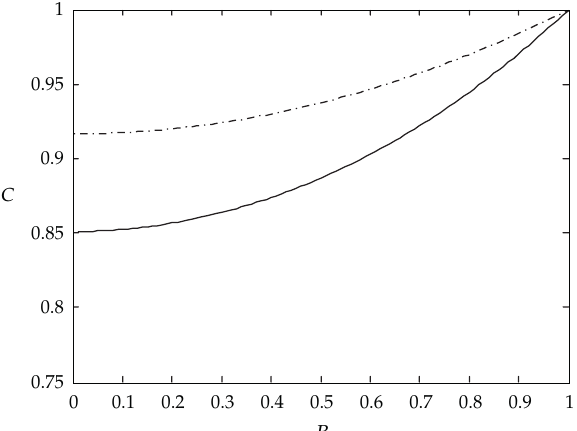
Figure 5: Comparison between exact solution and the approximate solution (cid:5) n (cid:7) 1, φ (cid:7) 1 (cid:6) . The dashed line presents an approximate solution, and the continued line presents the exact solution. The maximal error is about